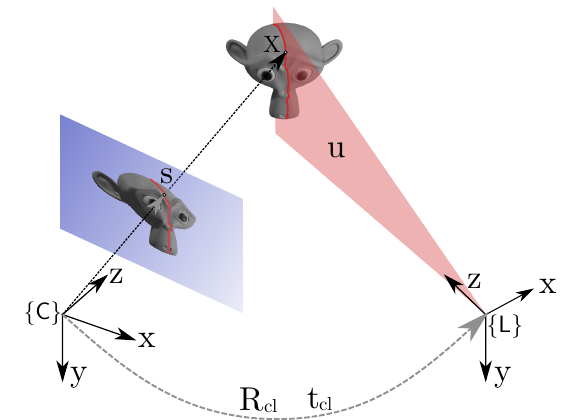
Figure 1: Laser scanner geometry. The camera frame is shown to the left and the laser frame to the right. The normalized image plane is drawn in front of the